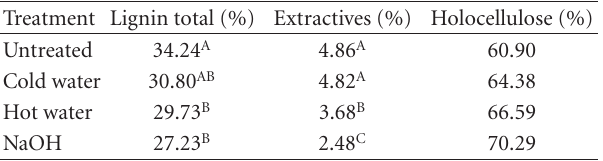
Table 3: Chemical composition of the coir fibre according to pre- treatment